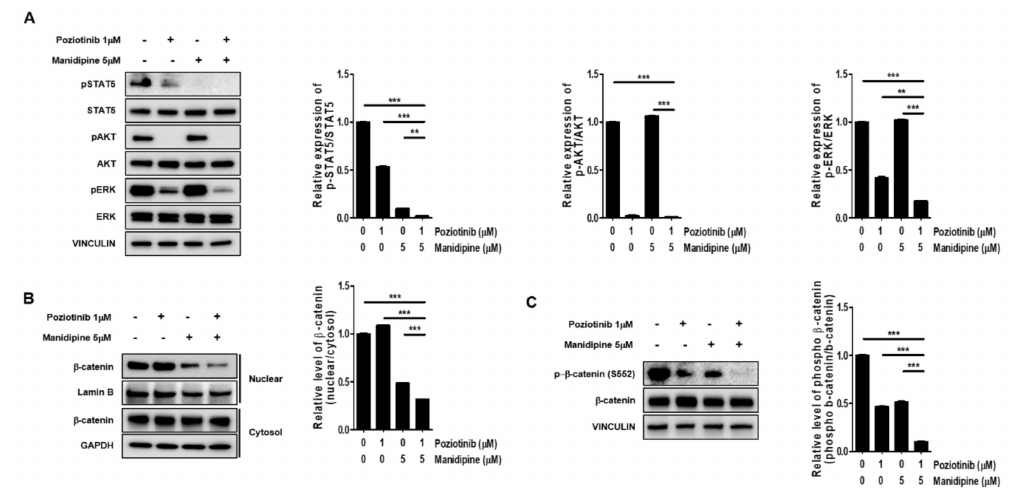
Figure 4. The e ff ects of poziotinib and manidipine alone or in combination on the expression of stemness-related signaling molecules in ovarian CSCs. ( A ) Expression levels of phosphorylated proteins were detected by Western blotting. A2780-SP cells were treated with poziotinib and manidipine at the indicated concentrations for 24 h, and the results are shown in a graph (right panel). ( B ) Protein levels of cytosolic and nuclear β -catenin were detected in A2780-SP cells treated with poziotinib and manidipine by Western blotting. The results are shown in a graph (right panel). ( C ) Levels of phospho- β -catenin (S552) and total β -catenin were detected in A2780-SP cells treated with poziotinib and manidipine by Western blotting. The results are shown in a graph (right panel). The data are expressed as the mean ± SD of two or three independent experiments. ** p < 0.01, *** p <